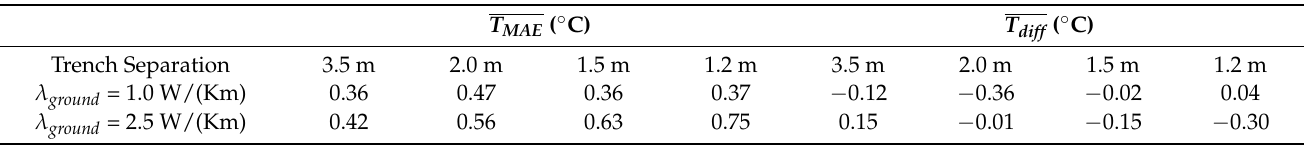
Table 5. T MAE and T dif f values for difference thermal conductivities with the straight pipe configuration (using the same configuration and separation with a thermal conductivity of 1.5 W/(Km) as reference data). T MAE ( ◦ C) T diff ( ◦ C) Trench Separation 3.5 m 2.0 m 1.5 m 1.2 m 3.5 m 2.0 m 1.5 m 1.2 m λ ground = 1.0 W/(Km) 0.36 0.47 0.36 0.37 − 0.12 0.04 λ ground = 2.5